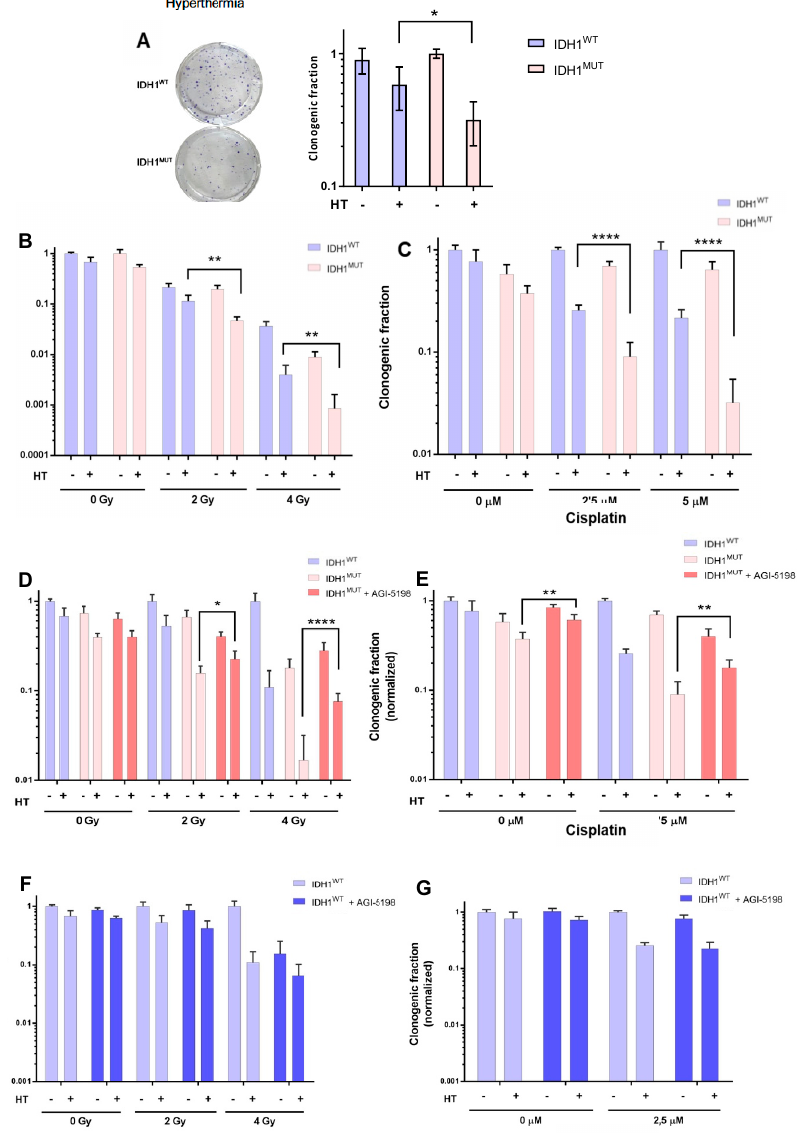
Figure 3. Clonogenic survival assays of HCT116 IDH1 WT and IDH1 MUT cells after combinations of anti-cancer treatment. ( A ) Images of crystal-violet-stained colonies (top IDH1 WT , bottom IDH1 MUT cells) at day 14 after hyperthermia (42 º C for 1 h) and survival assay. Clonogenic survival assay ( B )